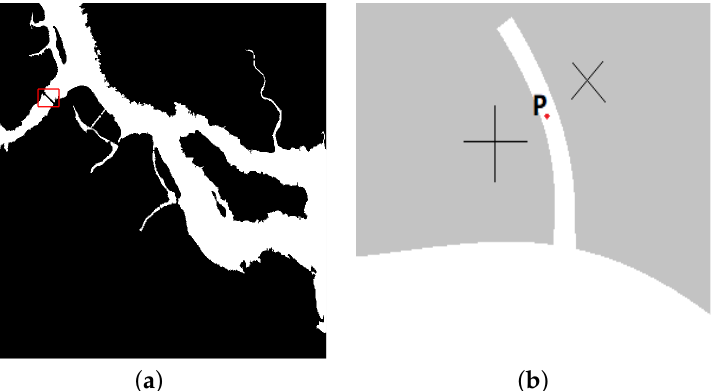
Figure 4. Bifurcation of the main water and diagram of bifurcation scanning: ( a ) diagram of bifurca- tion; ( b ) diagram of scanning, where P denotes a bifurcation pixel, and two crosses indicate two pairs of scanning directions.